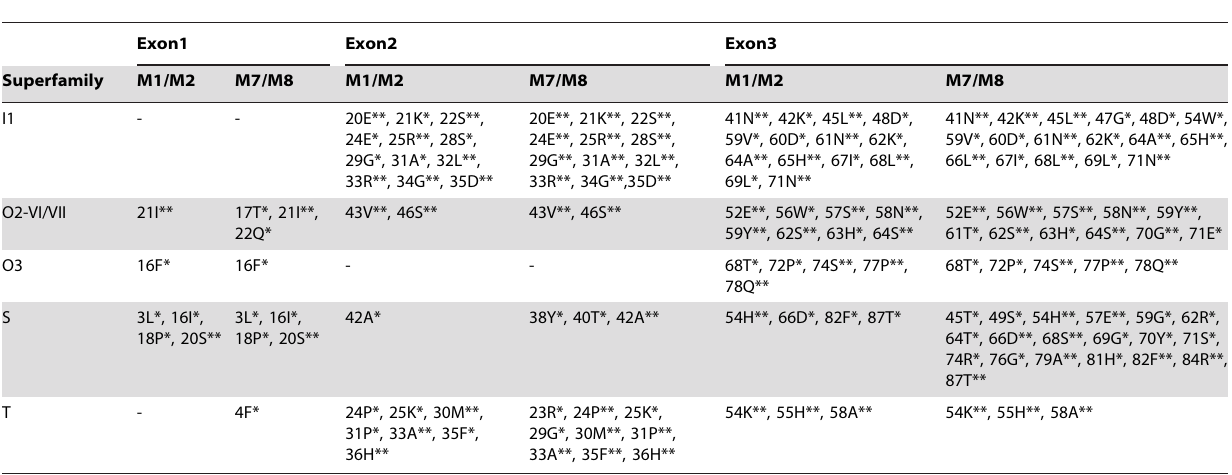
Table 7. Positively selected sites in other